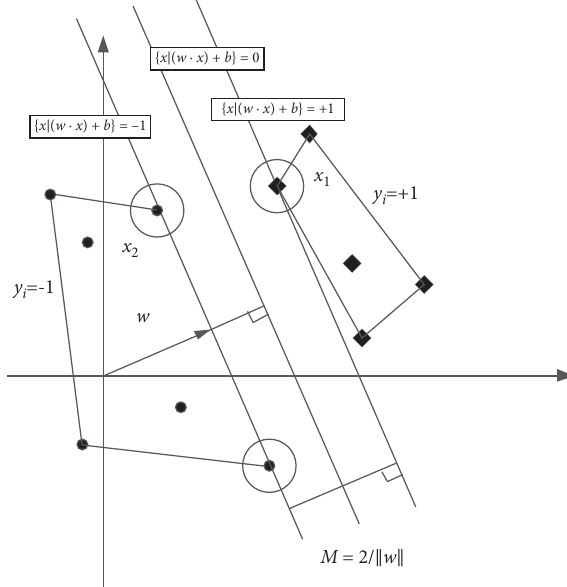
Figure 1: Optimal classification